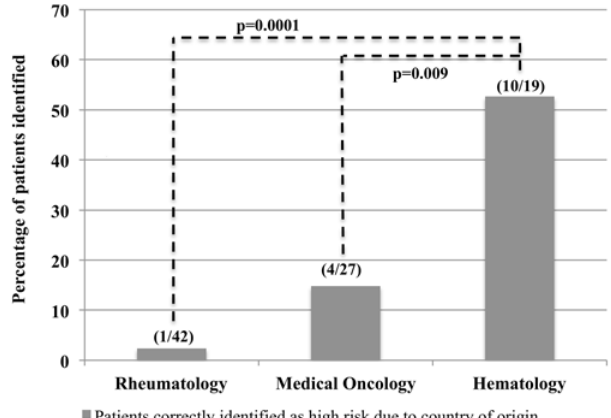
Fig 1. Physician ability to identify patients at high risk of chronic HBV infection based on country of origin. Patients originating from areas with greater than an intermediate rate ( (cid:1) 2) of chronic HBV infection, as determined by the CDC [16], were identified through the patient questionnaire. This figure illustrates the proportion of these patients who were correctly identified by their treating physician as being at high risk of HBV reactivation due to their country of